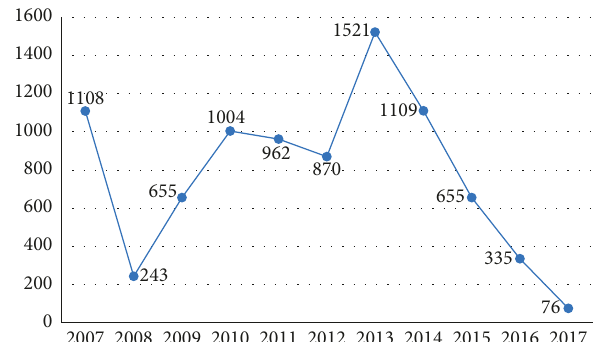
Figure 2: The citation details of the 526 papers in